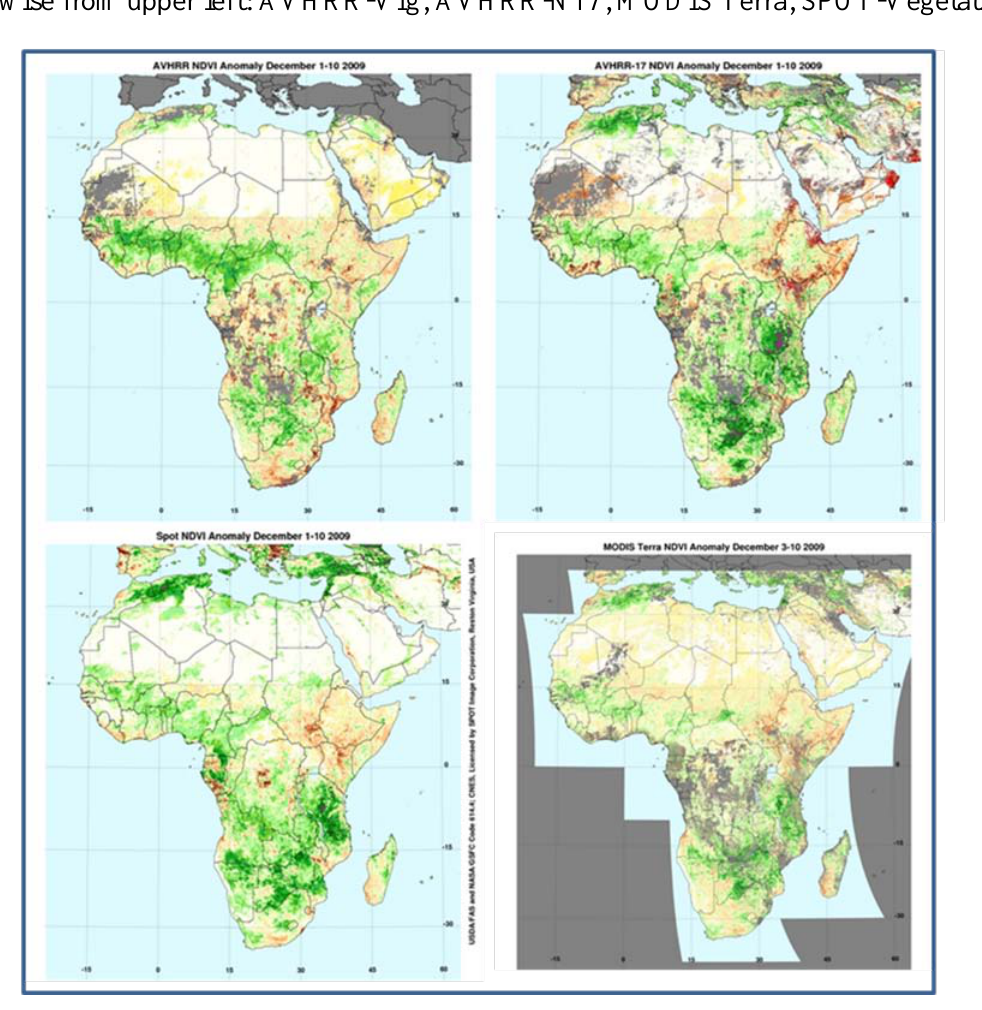
Figure 4. Example of near real time NDVI anomaly products for Africa. Data sources clockwise from upper left: AVHRR-VIg, AVHRR-N17, MODIS Terra,